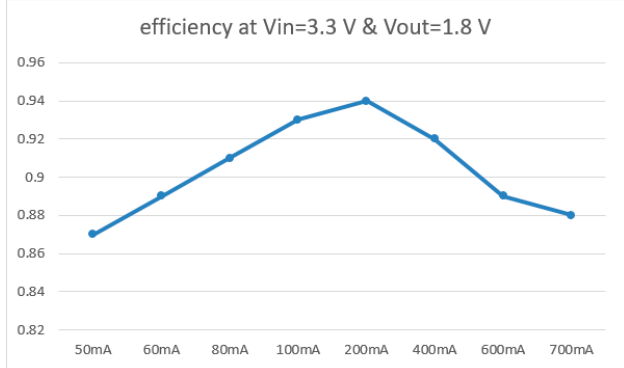
Figure 19. Measured conversion efficiency of the proposed DC-DC buck converter. Table 1. Specification of the proposed DC-DC buck converter.